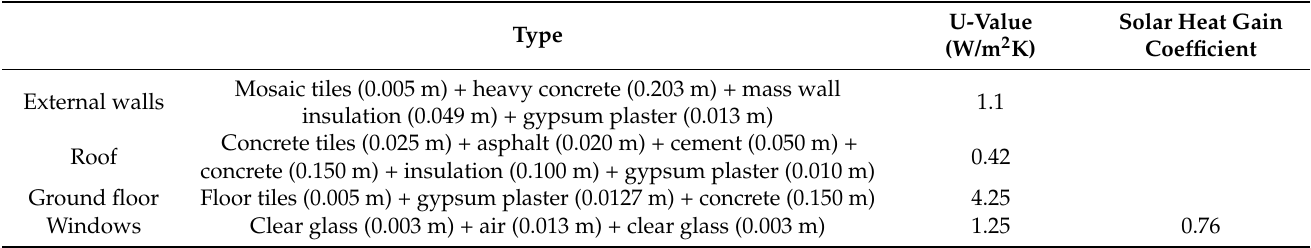
Table 3. The type of building fabrics, along with their thermal properties.